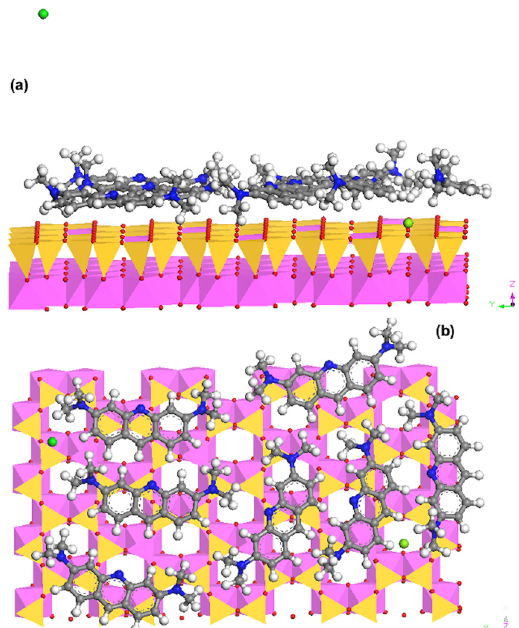
Figure 10. Molecular dynamics simulation showing condensed AO monolayer configuration on HAL ( a ) at the AO sorption capacity ( b ). Zn: green.